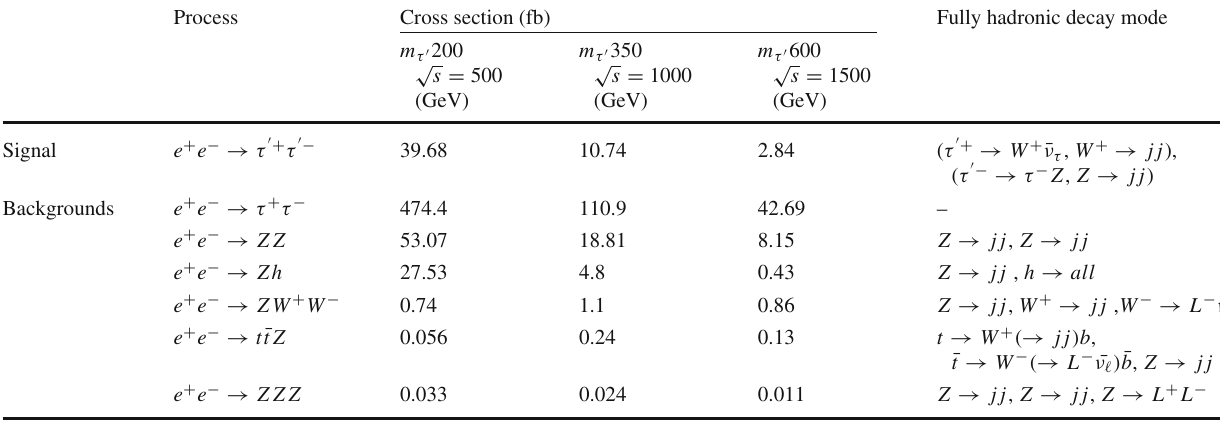
Table 7 The processes and cross sections of the signal and backgrounds for three benchmark points in fully hadronic channel, where L ± = (cid:10) ± ,τ ± . The conjugate processes of the signal and backgrounds have been considered Process Cross section (fb) Fully hadronic decay